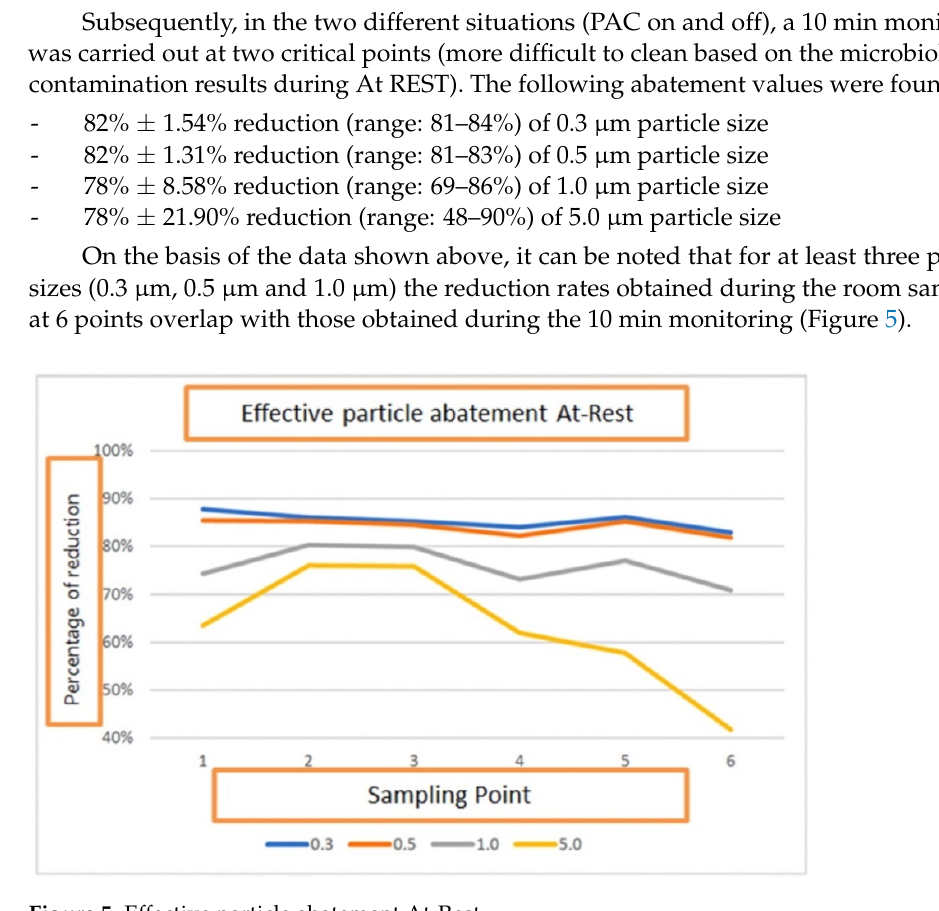
Figure 5. Effective particle abatement At-Rest.